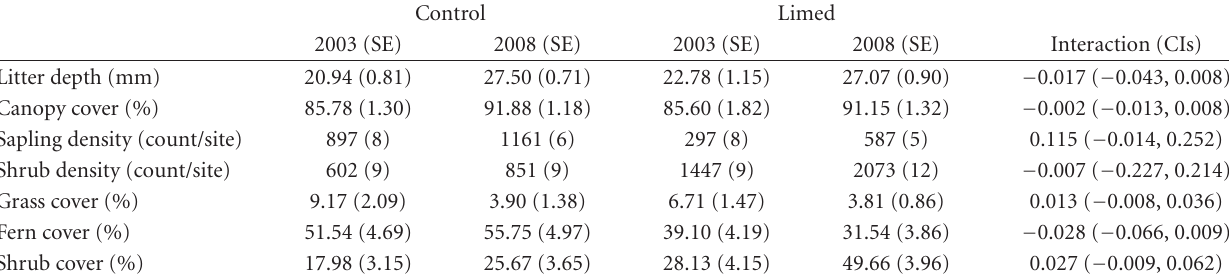
Figure 1: Mean soil pH, soil exchangeable calcium (Ca), magnesium (Mg), potassium (K), and phosphorus (P) in cmol/kg and soil Ca:Al ratio with SE bars on lime-treated and control sites with model lines. Lime treatment was applied between 2003 and 2004 in central Pennsylvania. ∗ Confidence intervals of the time-by-treatment interaction excluded zero, indicating a significant e ff ect of liming on that variable. Table 1: E ff ect of liming on vegetation, with parameter estimates for the year-treatment interactions with 95% highest posterior density (HPD) intervals from Markov Chain Monte Carlo samples from repeated measures analysis of data collected in PA before and after lime application on two of four forest sites. All of the confidence intervals (CIs) include zero, indicating no significant e ff ect of liming on those